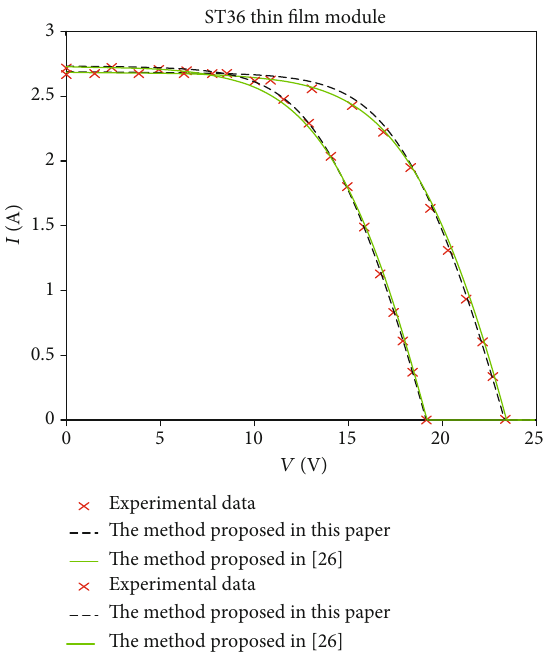
Figure 9: I – V characteristics under varying temperature for ST36 thin fi lm module ( G = 1000 W/m 2 ). Table 7: Time on extracting parameters from three kinds of PV modules by di ff erent methods.